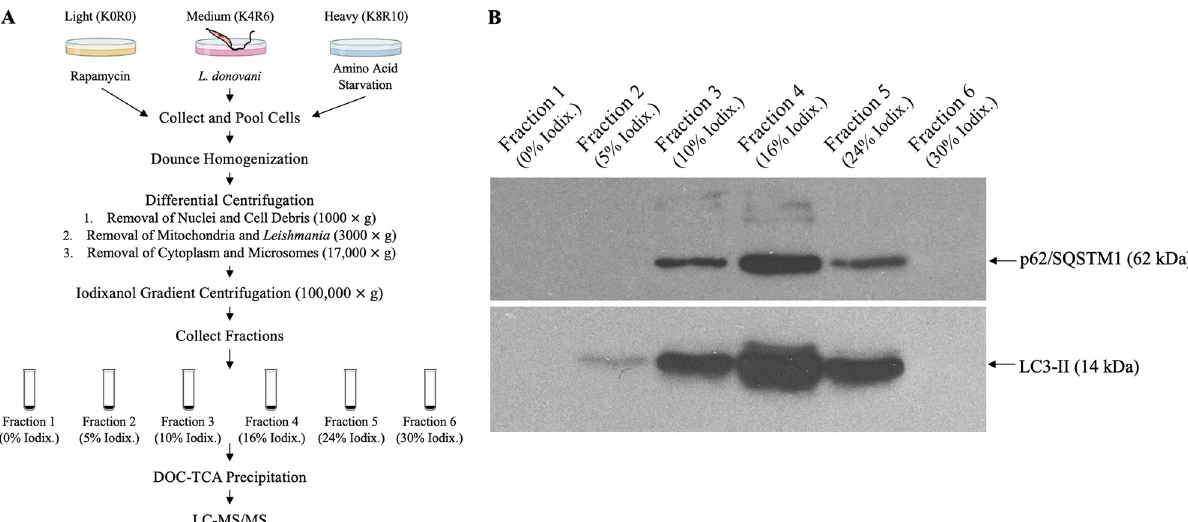
Fig 1. Preparation of samples for LC/MS analysis. A) Flow diagram outlining the autophagosome purification workflow in preparation for mass spectrometry analysis. THP-1 cells were stable isotope-labeled, differentiated, and subsequently treated with either 12.5 μ g/mL rapamycin for 2 h, infected with Leishmania donovani at an MOI of 20:1 for 24 h or starved with HBSS for 4 h and treated with 100 nM Bafilomycin A1 for the last 3 h. To minimize quantitative error, the cells were mixed at an early stage and lysed via Dounce homogenization. Autophagosomes were purified via differential centrifugation, followed by iodixanol gradient centrifugation. Six fractions were collected, and samples were concentrated by 10% DOC-TCA precipitation. Fraction four (16% iodixanol) was subjected to LC/MS analysis. B) Western blot analysis of 10% DOC-TCA precipitated iodixanol gradient fractions for the autophagosome marker LC3-II and SQSTM1/p62. A representative image from three independent experiments is shown.